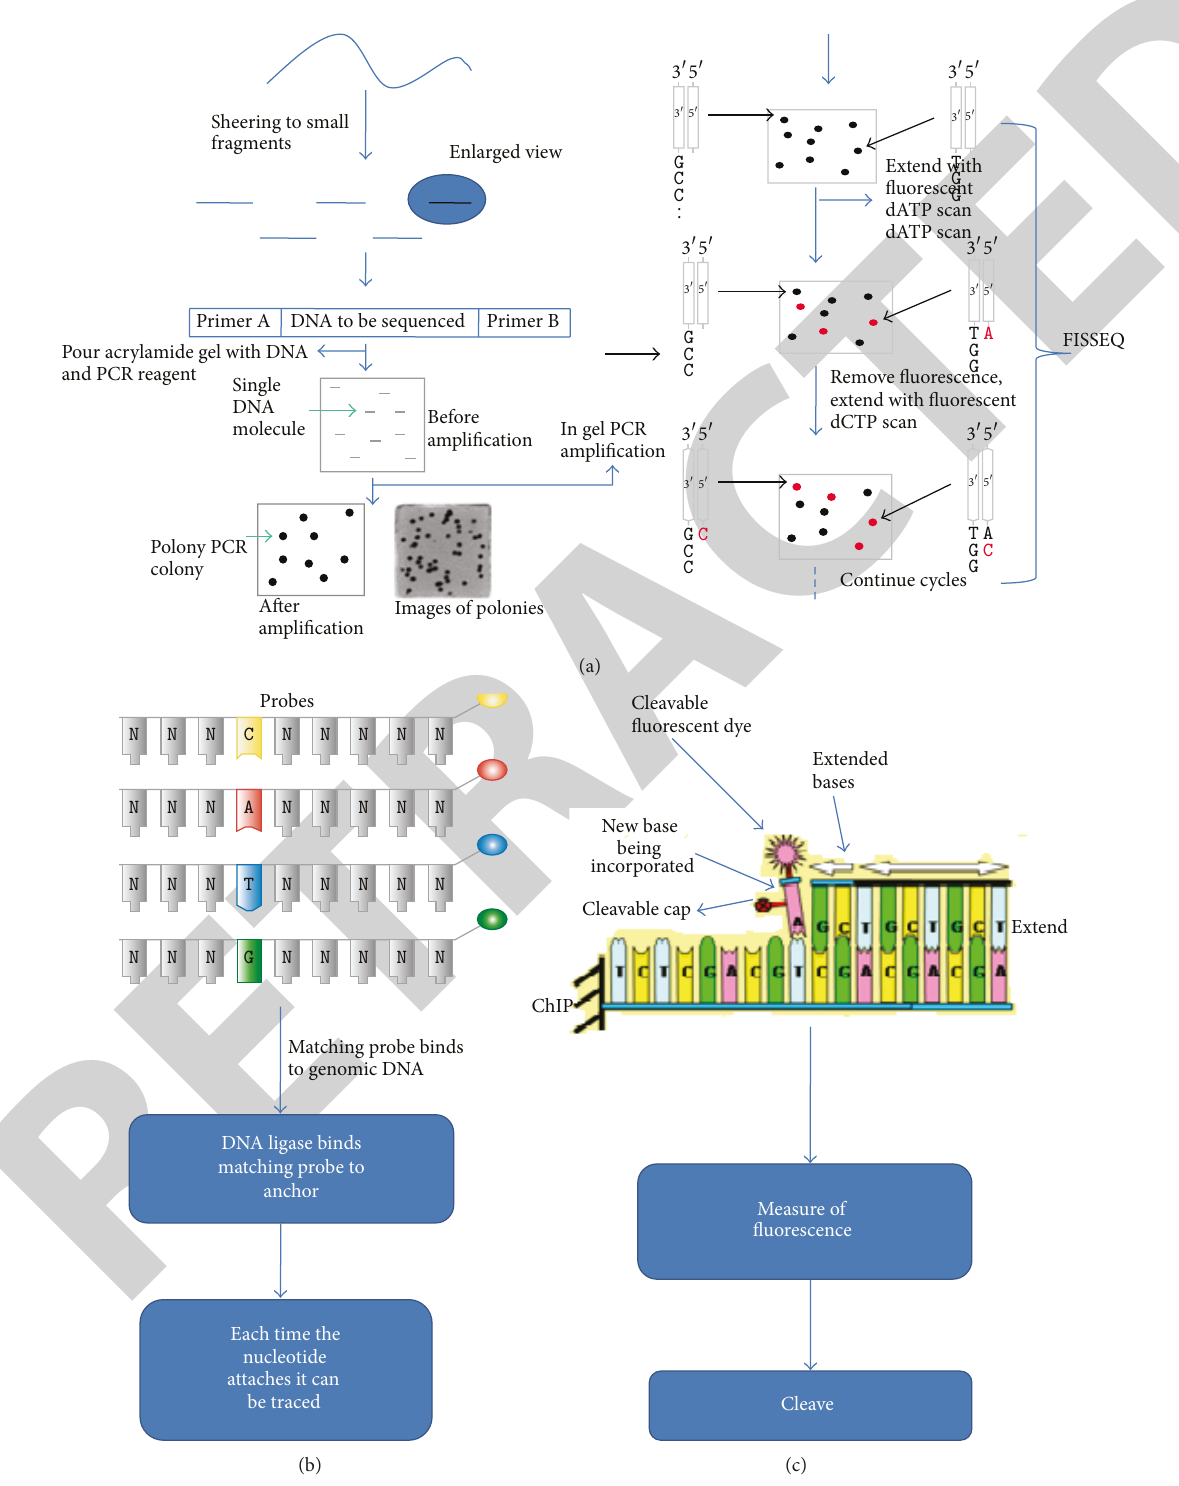
Figure 1: Different techniques of next generation sequencing: (a) polony sequencing; (b) sequencing by Ligation; (c) sequencing by